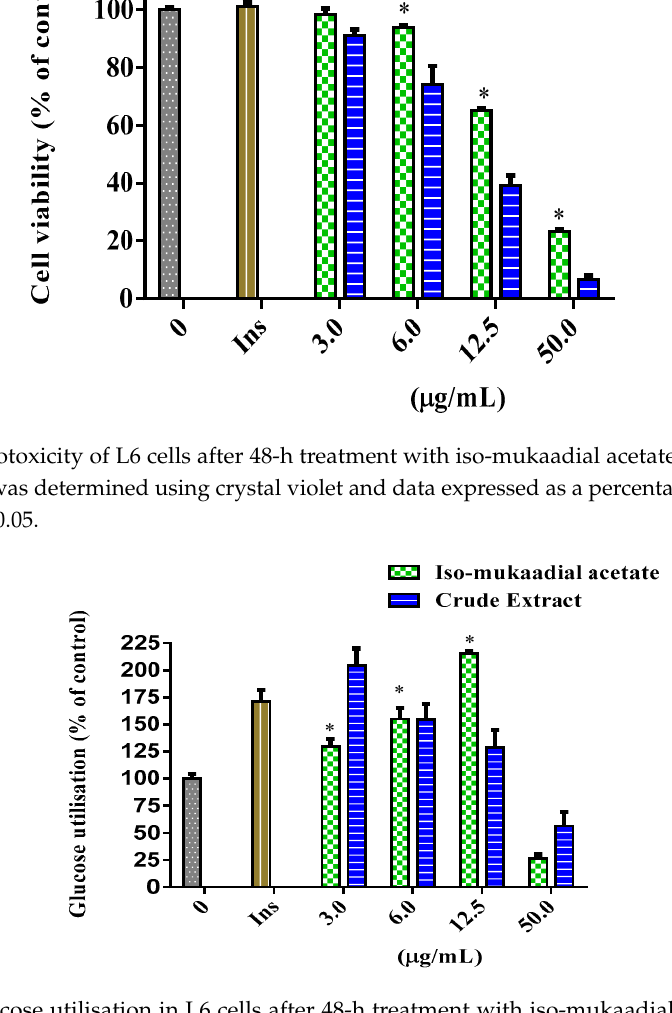
Figure 3. Glucose utilisation in L6 cells after 48-h treatment with iso-mukaadial acetate and crude extract. Glucose utilisation is calculated as the difference in remaining glucose after 2 h incubation between the no cell control and cells with the respective treatments. Data is expressed as a percentage relative to the untreated control, * p <